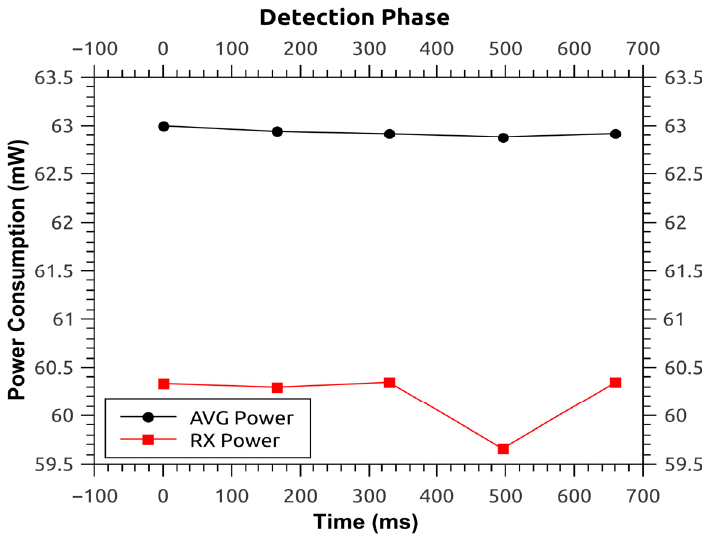
Figure 15. Power consumption for protocol—detection phase.